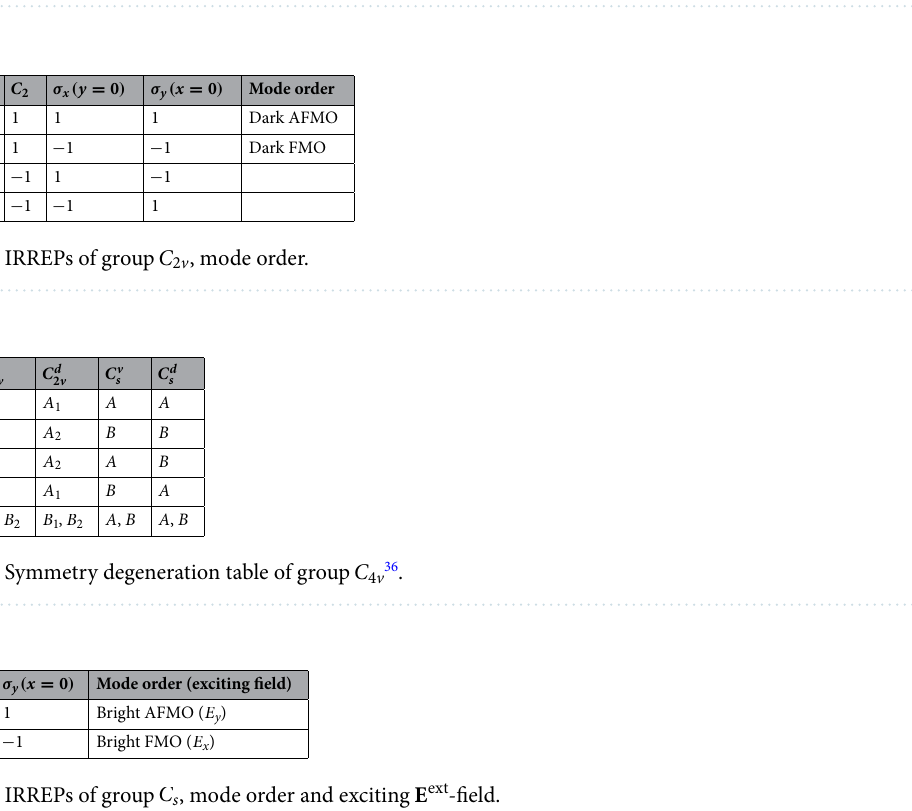
Table 1. IRREPs of group C 4 v , mode order and transformation of 2D electric field E ext of incident wave.